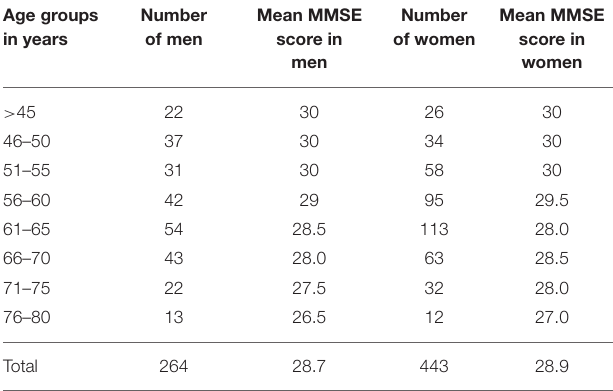
TABLE 1 | Distribution of men and women as well as their Mini-Mental State Examination (MMSE) scores in different age groups. Age groups in